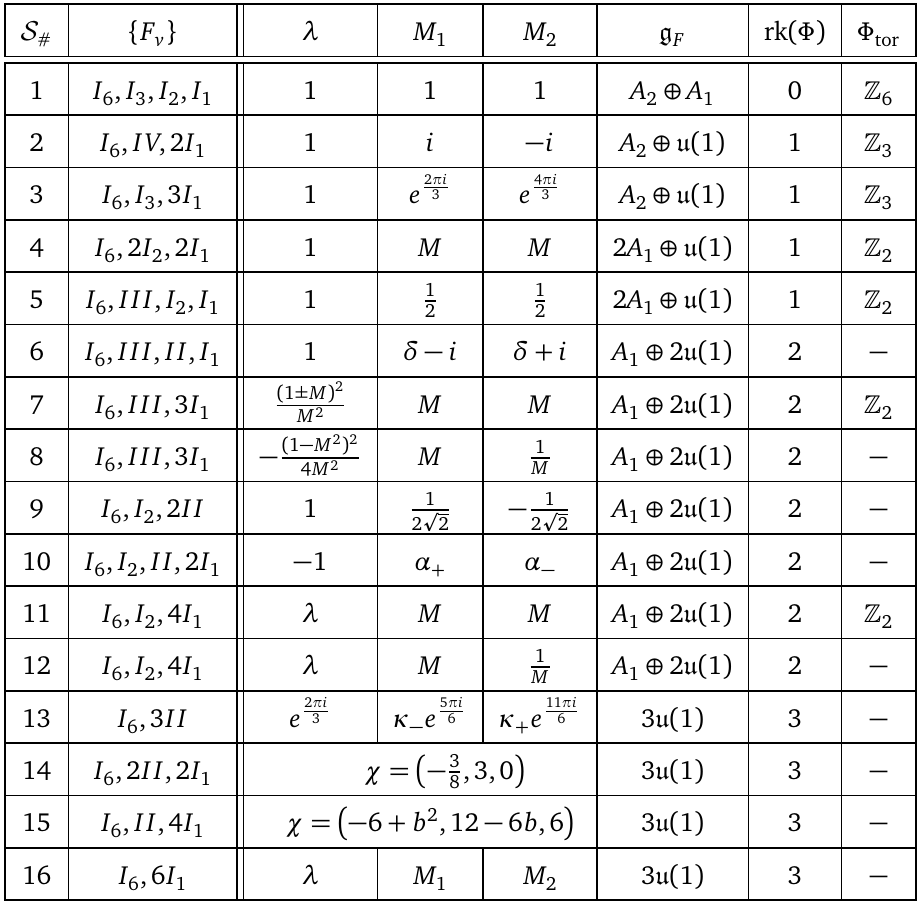
Table 11: Allowed configurations of singular fibres on the Coulomb branch of the E D theory. Here, we have δ = 3 S 1 3 and b ∈ (cid:67)